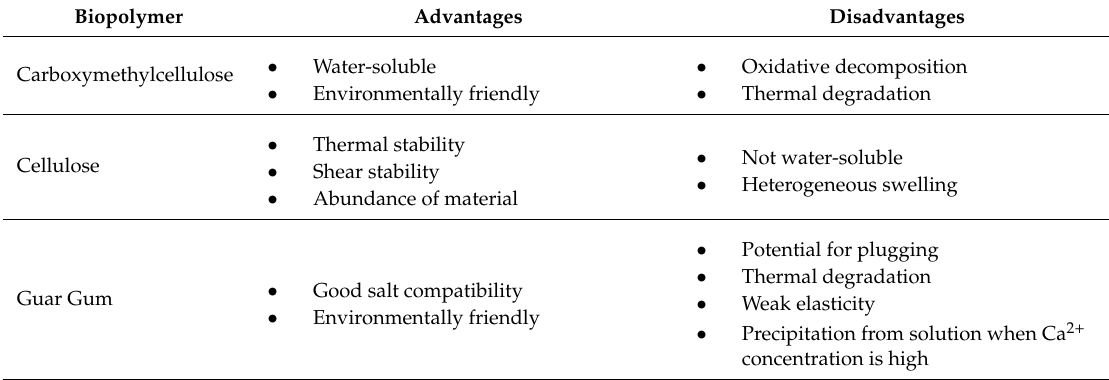
Table 2. Potential biopolymers for polymer-flooding EOR (adapted from [7] with additional information from